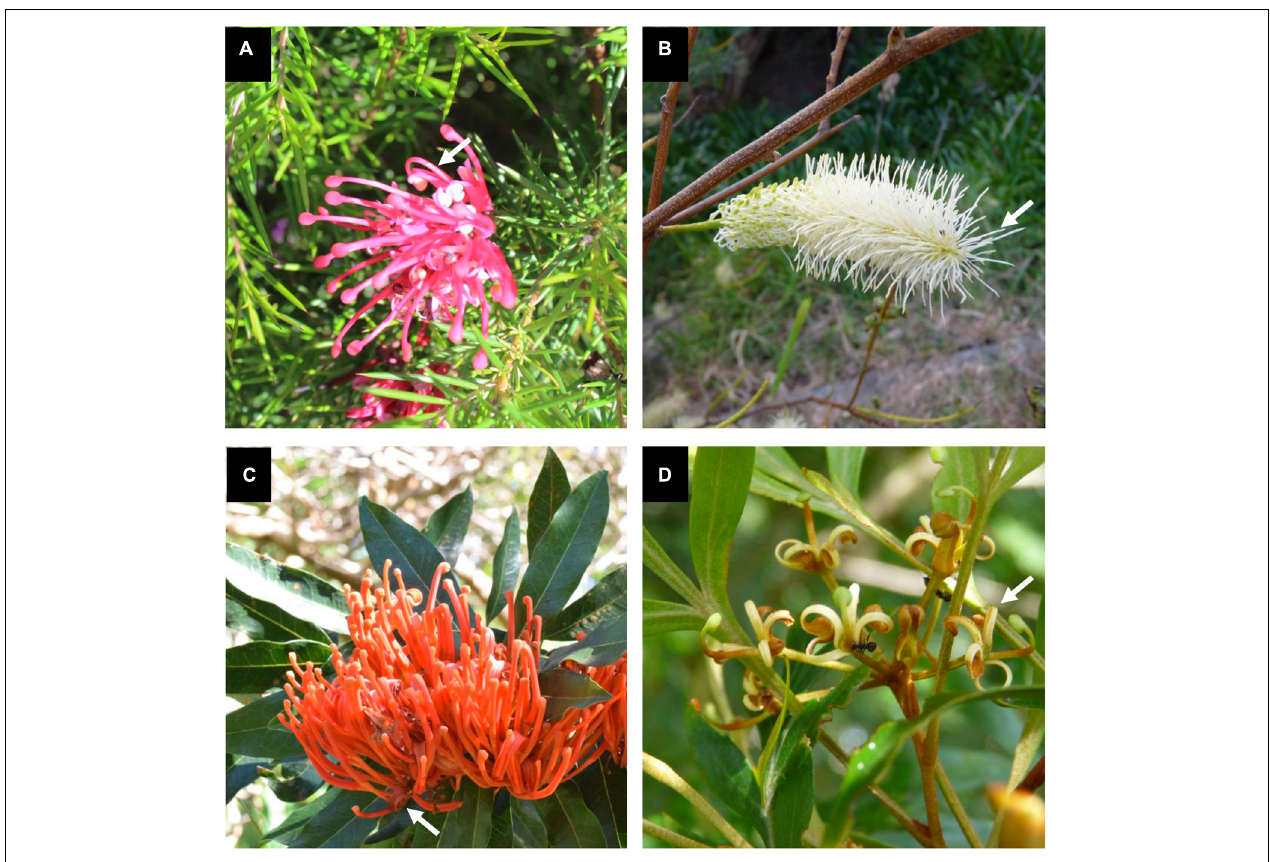
FIGURE 1 | Inflorescences of the study species. All species have tetramerous flowers with stamens completely adnate to tepals. (A) Inflorescence of Grevillea juniperina with zygomorphic flowers at anthesis (arrow pointing to an open flower displaying curved tepals and style). (B) Inflorescence of Grevillea petrophiloides with actinomorphic flowers at anthesis (arrow pointing to an open flower displaying straight tepals and style). (C) Inflorescence of Alloxylon flammeum with zygomorphic flowers at anthesis (arrow pointing to an open flower displaying curved tepals and style). (D) Inflorescence of Stenocarpus davallioides with zygomorphic flowers at anthesis (arrow pointing to an open flower displaying curved tepals and style). Photographs S. Nadot (A) and H. Sauquet (B–D)